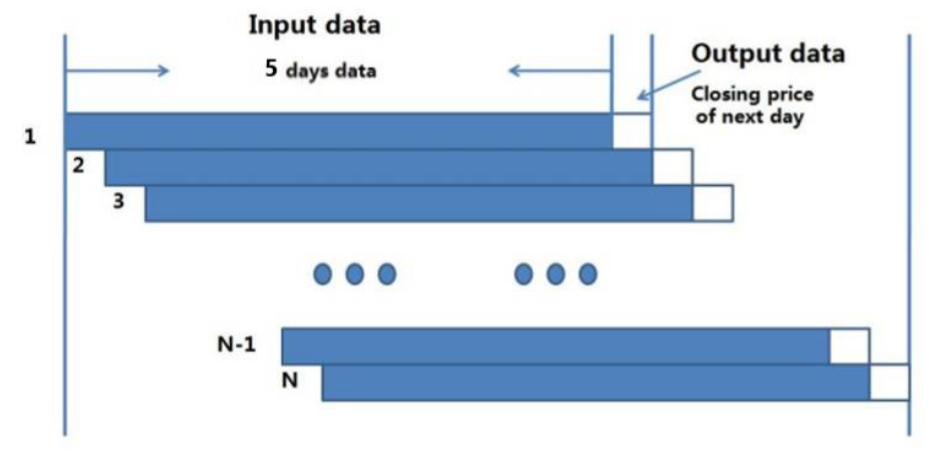
Figure 3. Diagram of building up the sequence